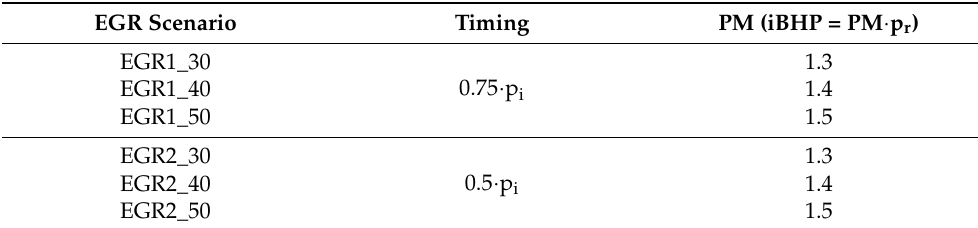
Table 2. List of simulation scenarios.